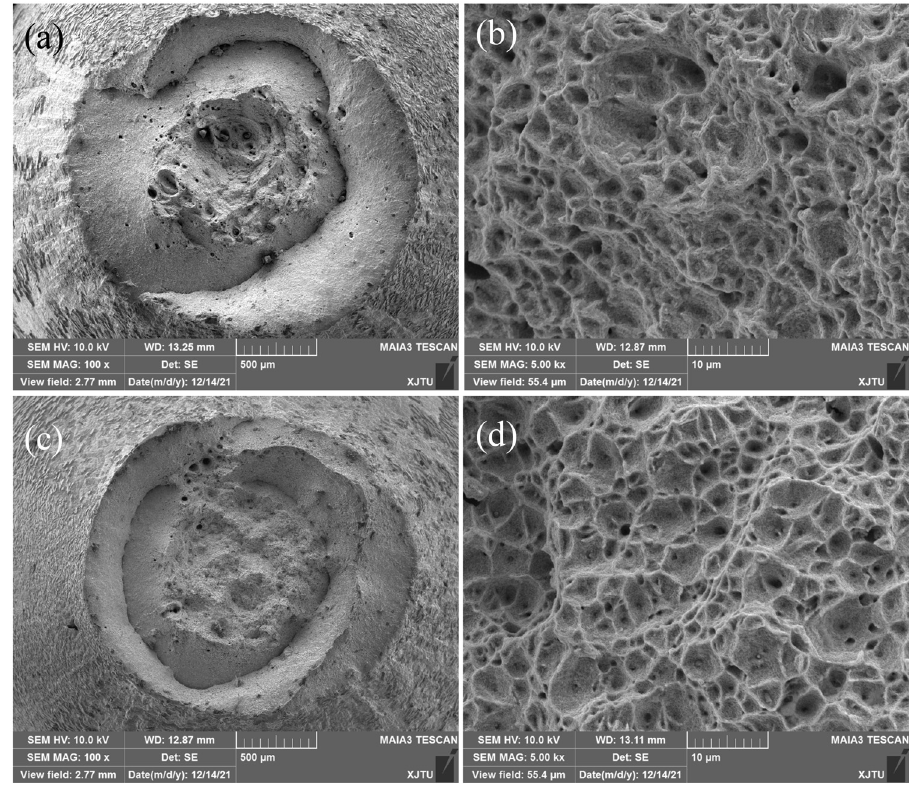
Figure 11: SEM fracture morphologies of the creep ruptured ( a and b ) BM and ( c and d ) WM specimens at 550°C under the stress of 325